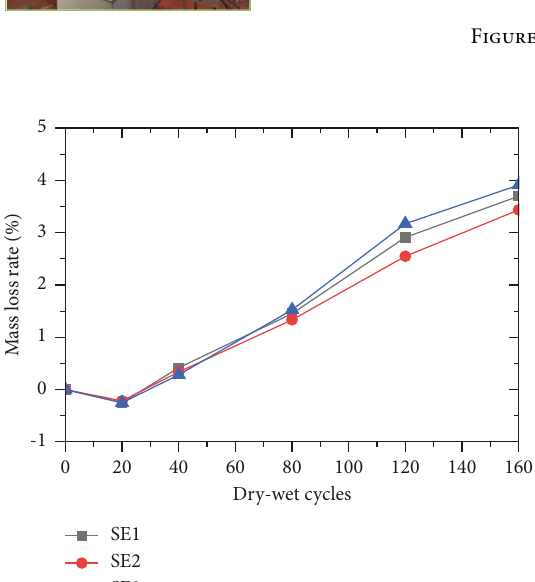
Figure 2: Test flow chart.